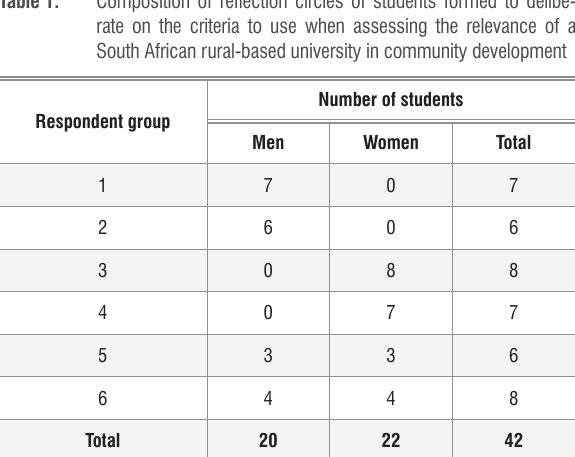
Figure 1: Schematic presentation of the reflection circles constituted in the exploratory study on the relevance of a South African rural area based university in community development. Composition of reflection circles of students formed to